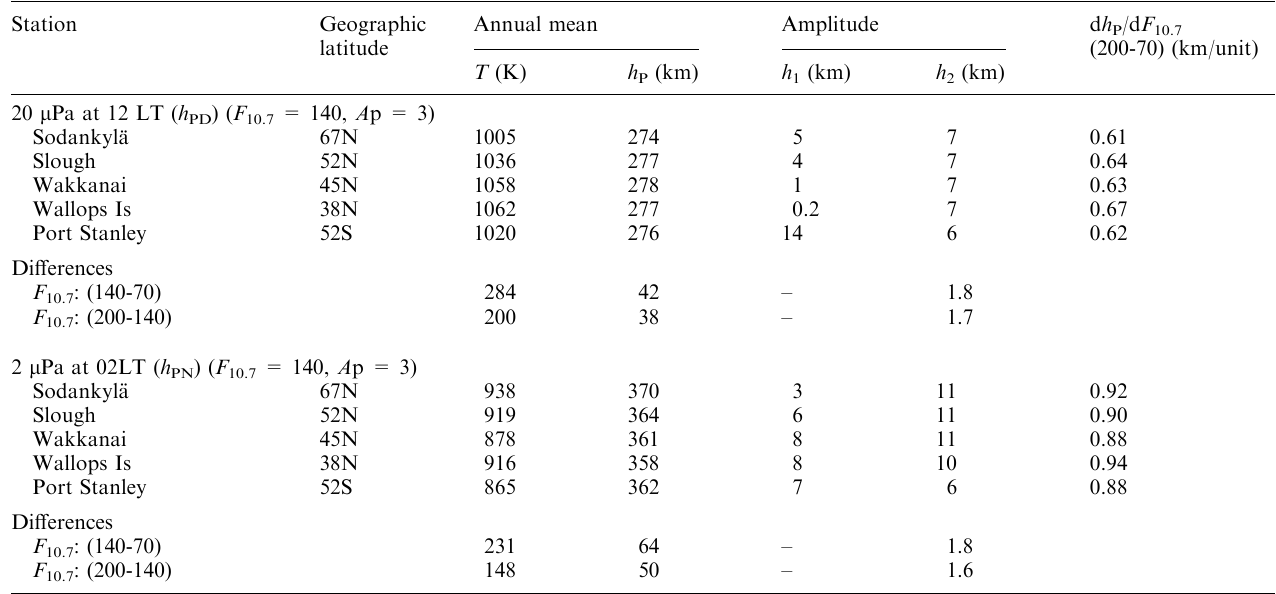
) and annual and (not shown for the annual component the variations with F P 10.7 because they vary considerably between stations). See text